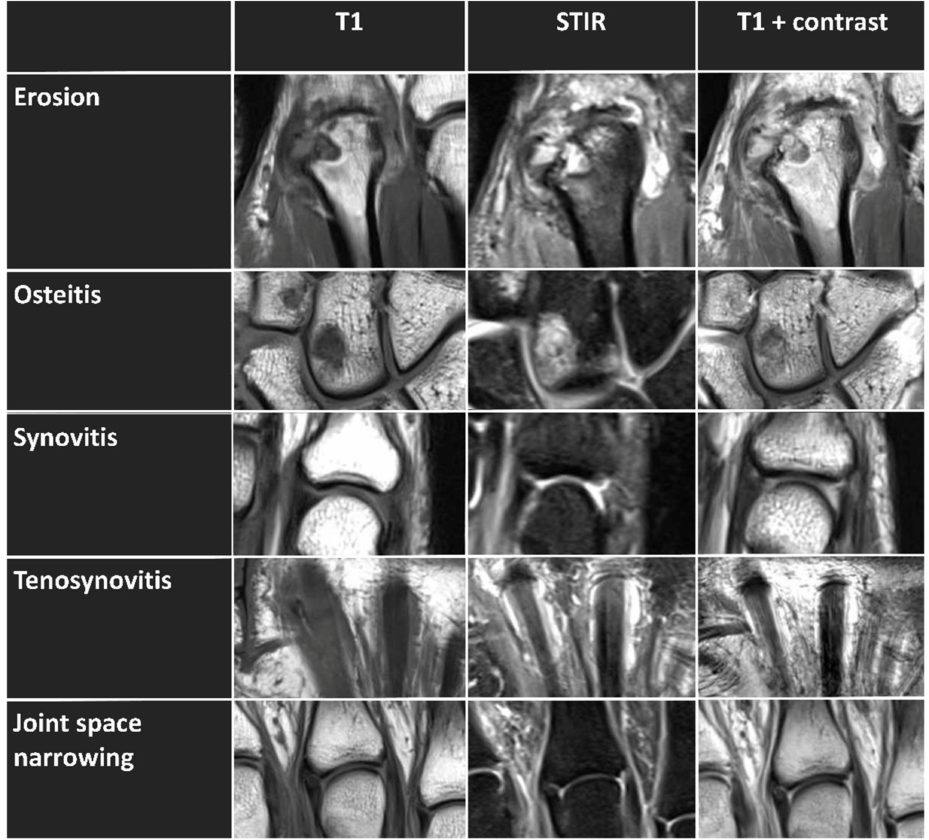
Figure 1. Exemplary imaging features (erosion, osteitis, synovitis, tenosynovitis, and joint space narrowing) that are scored semiquantitatively based on RAMRIS, shown in unenhanced MRT T1- weighted sequence (left column), STIR sequence (middle column), and enhanced T1-weighted postcontrast sequence (right column). Erosion is visualized at the bare area of the distal metacarpal bone of the second digit (i.e., the MCP joint base) of the right hand of a 48-year-old male patient. Osteitis is visualized in the right carpal bones with bone marrow edema in the capitate and trapezoid of a 56-year-old female patient. Synovitis is visualized in the right metacarpophalangeal joint of the fifth digit of a 53-year-old female patient. Tenosynovitis is visualized around the right flexor tendon of the second and third digit of a 75-year-old female patient. In the last row, metacarpophalangeal joints of the right hand with normal joint space without evidence of cartilage loss of a 52-year-old female patient are